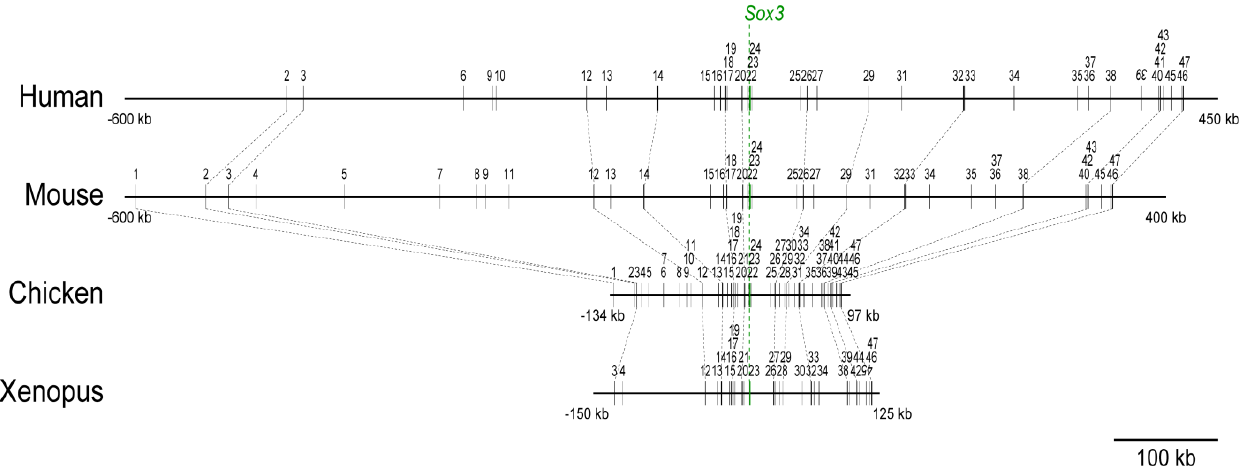
Figure 1. Comparison of the genome sequence organization of the Sox3 -encompassing regions of human, mouse, chicken and Xenopus. The arrangement of the conserved sequence blocks (CSBs) that were numbered 1 to 47 in the region, between 134 kb upstream and 97 kb downstream, of the chicken Sox3 gene. A CSB is defined as a sequence that shows > 60% base identity compared with the chicken genome of more than a 100 bp sequence. The corresponding CSBs in different genomes bear the same numbers as in the chicken. The spacing between CSBs are similar for chicken and Xenopus genomes, but are widened in mammalian genomes. Human CSB1 positioned at -970 kb is not included in this Figure. Downstream, the correspondence between the mammalian and chicken sequences is lost beyond CSB47. The genomic coordinates of the CSBs in each genome are given in Table